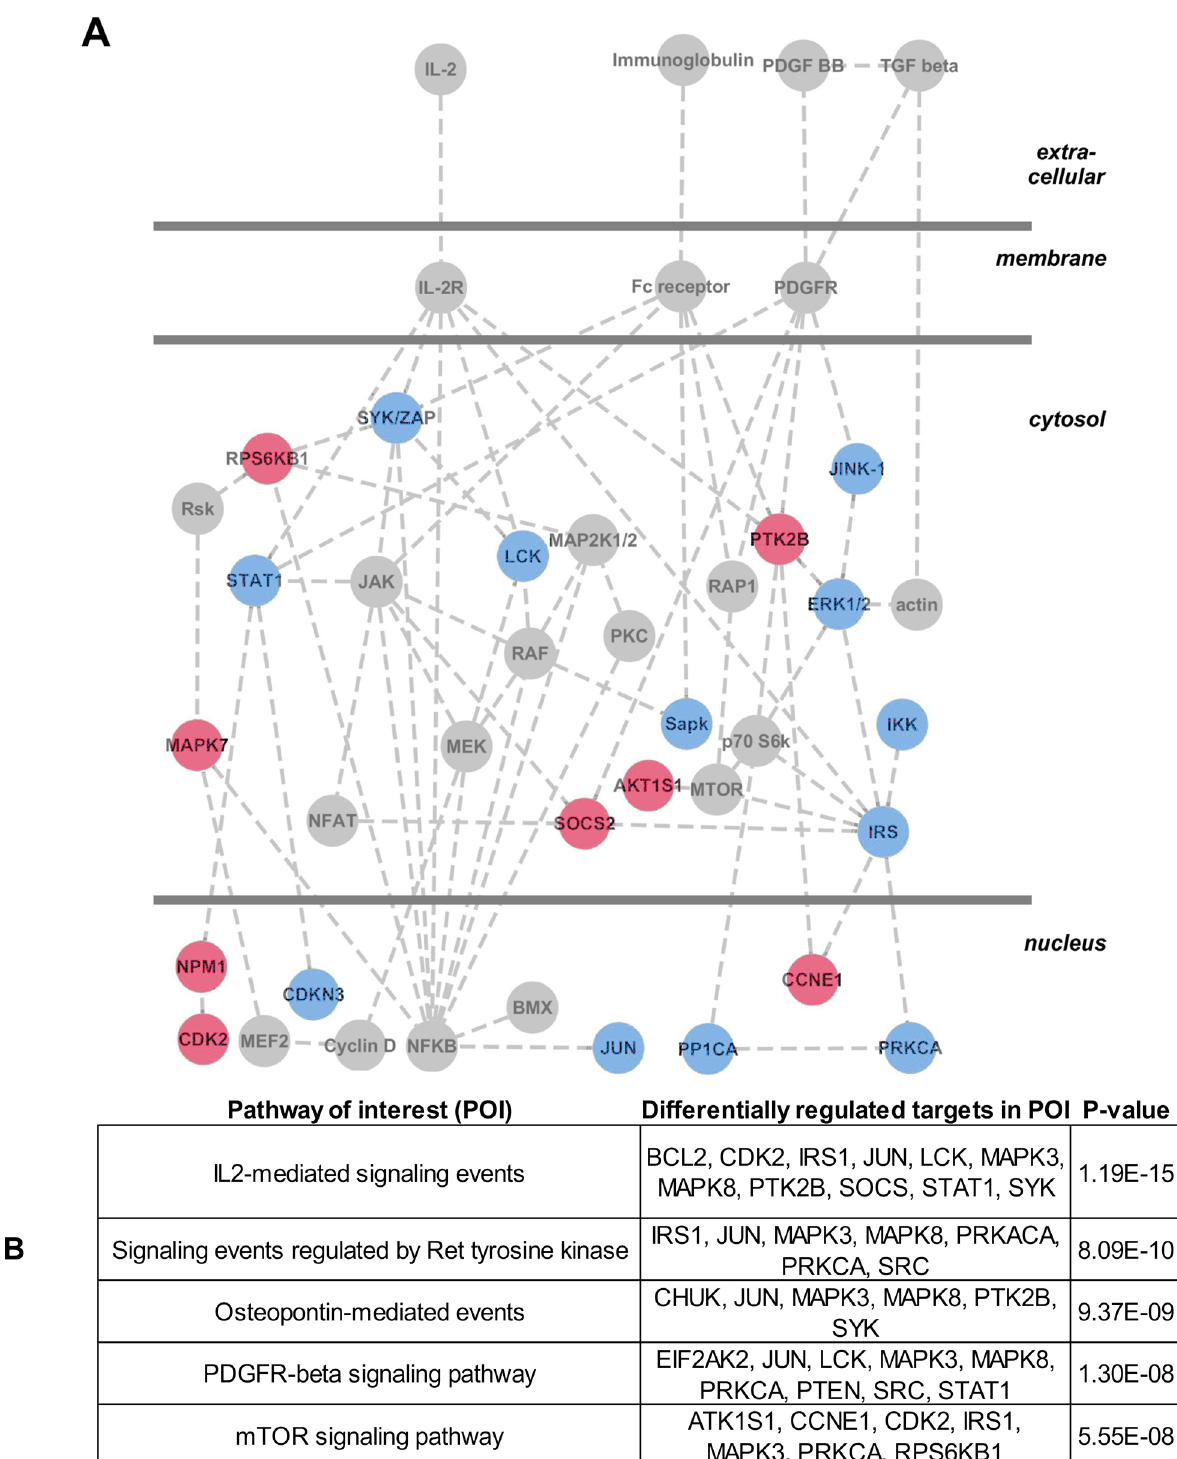
Fig 5. Kinomic screening and prediction of the signalling events that underlie plasmin-mediated immunomodulation. (A) MoDCs were incubated in the presence/absence of 1 nM t-PA and 100 nM plasminogen. 3 h later cultures were lysed and subject to kinomic microarray analysis yielding a short list of 31 signalling proteins that were differentially regulated upon plasmin-treatment (see S1 Table for complete dataset). The short list was subjected to Ingenuity Pathway Analysis to yield three canonical signalling pathways (not shown) for plasmin-mediated immunomodulation, which were manually merged and refined to generate a single putative signalling pathway that underlies plasmin-mediated immunomodulation. Red symbols represent upregulated events.